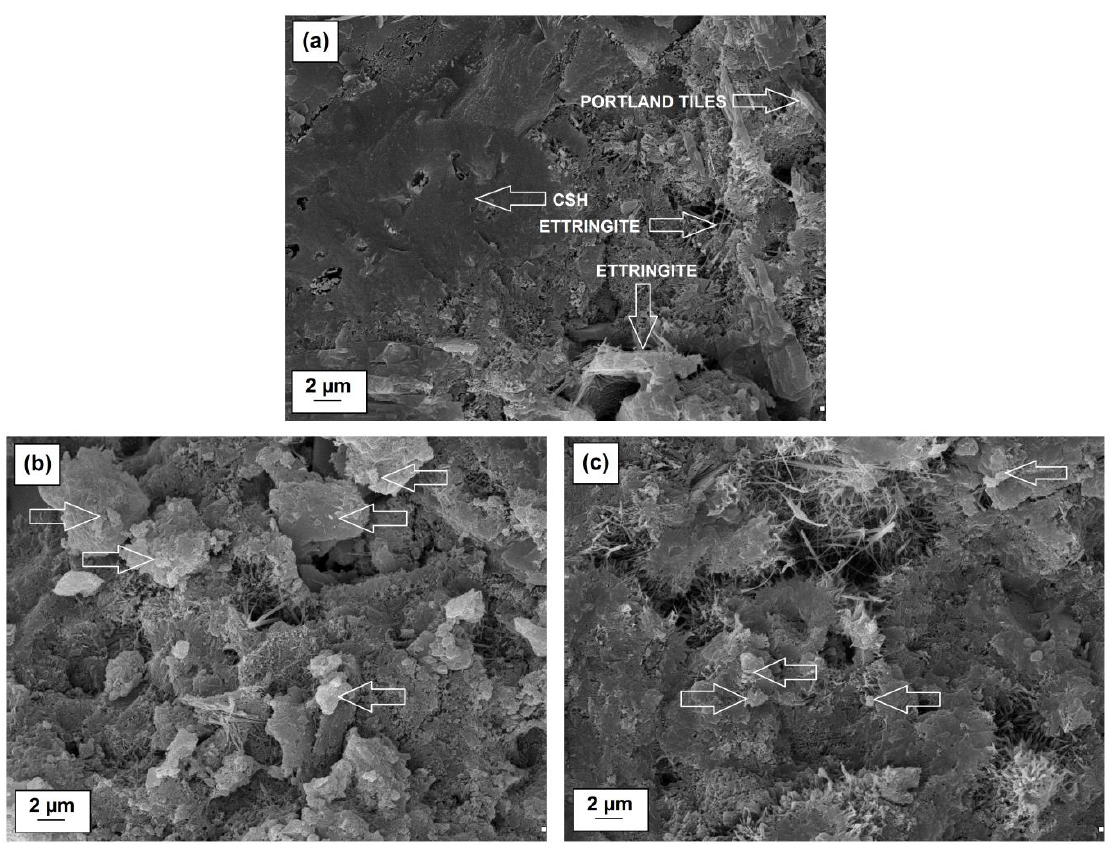
Figure 10. SEM images of pure cement mixture ( a ) and cement mixture with the addition of silica-lignin hybrid materials with weight ratios 5:1 wt./wt. ( b ) and 1:5 wt./wt. ( c ). ( b , c )–hybrid particles are marked with arrows.